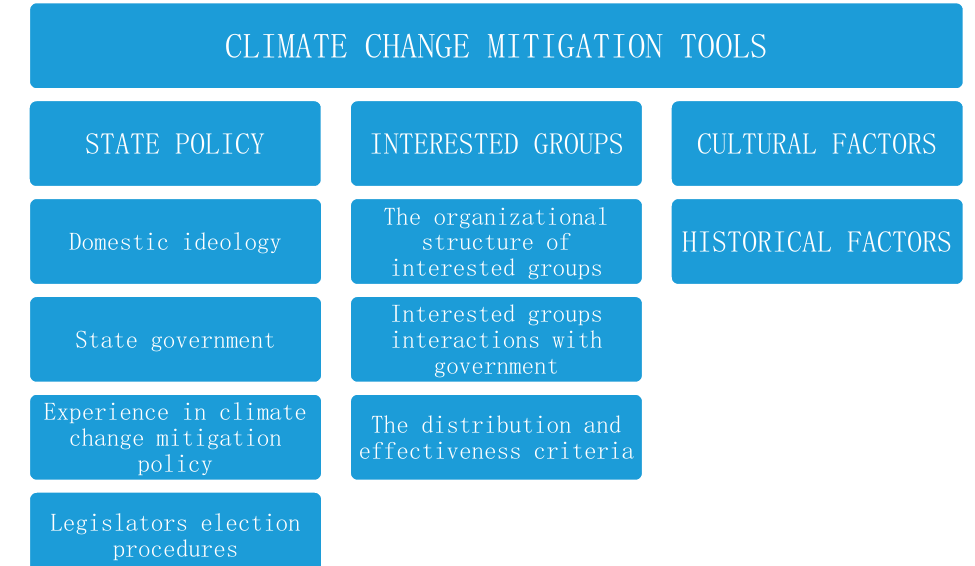
Figure 1. Factors determining climate change mitigation measures.